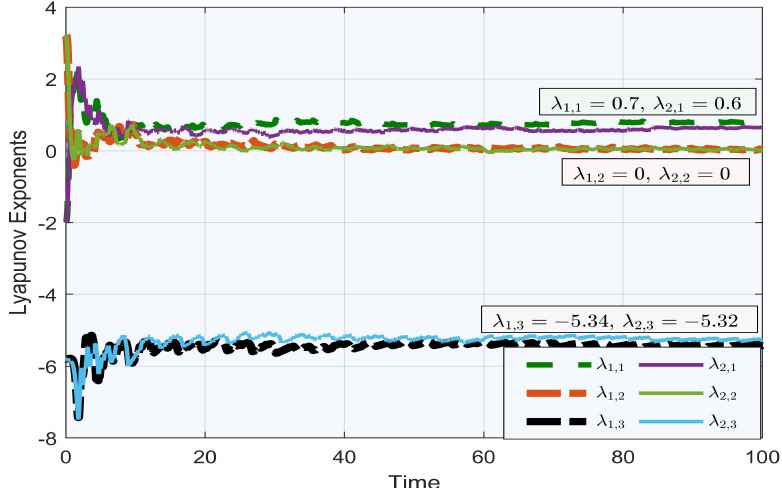
Figure 9. Lyapunov exponents λ 1, i ; i = 1,2,3 for the chaotic attractor and λ 2, i ; i = 1,2,3 for the coexisting